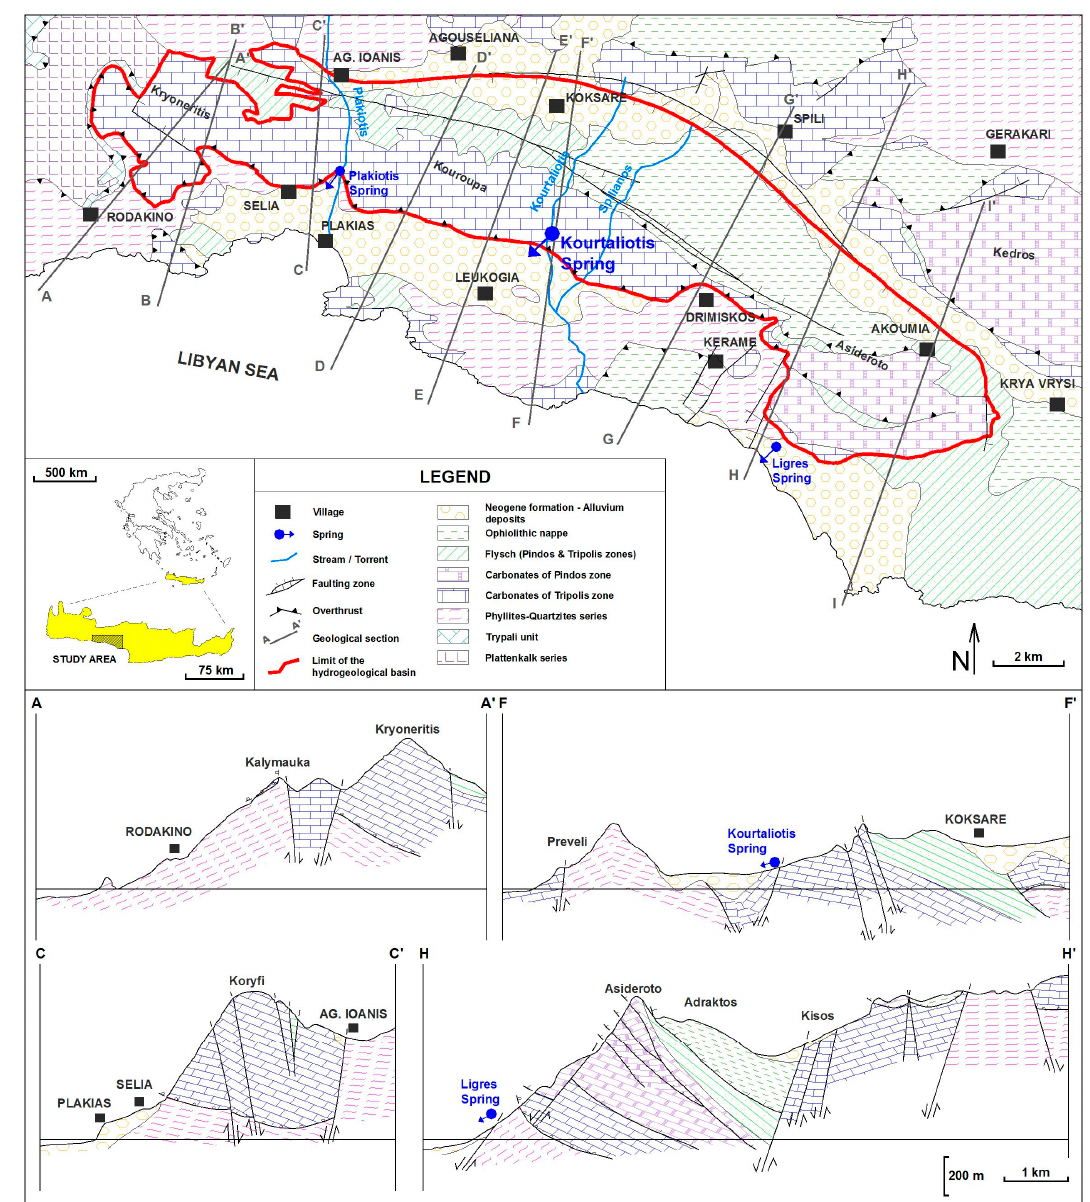
Figure 1. Geological map and structural cross-sections of the region. The black square on the inset map indicates the study area. The Kourtaliotis spring catchment is delineated in the figure by the red line.